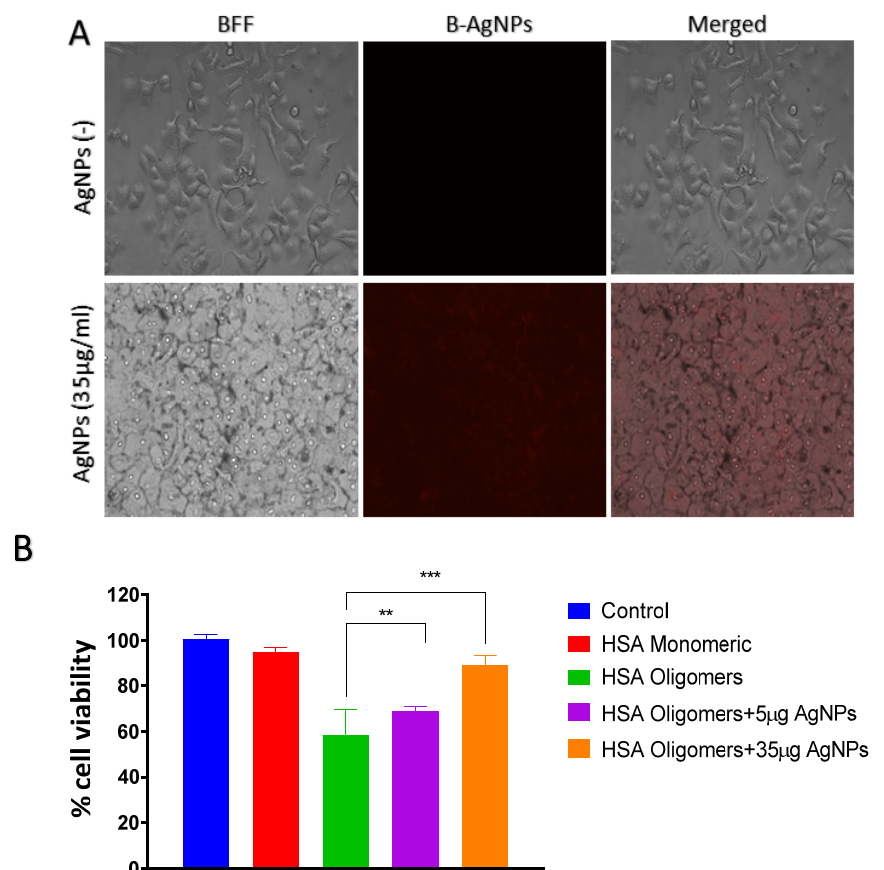
Figure 7. ( A ) Astrocytes uptake B-AgNPs: Astrocytes were grown overnight on the glass cover slip. When B-AgNPs were incubated with astrocytes, the NPs were taken up in a concentration-dependent manner. Micrographs of cells in the absence or presence of B-AgNPs at a magnification scale of 10X. ( B ) MTT assay for Cell Viability: The MTT cell viability assay was used to determine the capacity of as-synthesized B-AgNPs to suppress the formation of hazardous HSA aggregates. Although HSA aggregates are toxic to the cells, the addition of B-AgNPs inhibits the formation of HSA aggregates. Experiments were performed in triplicates, results are shown as mean ± SD; ** p ≤ 0.01; *** p ≤ 0.001.